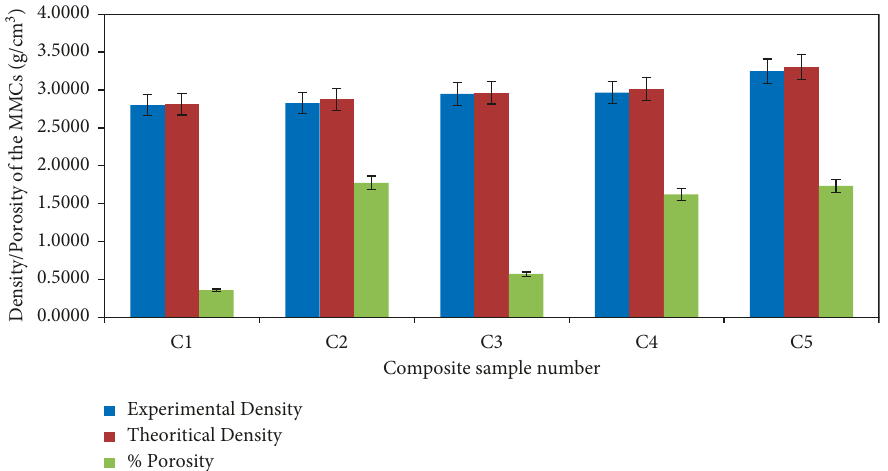
Figure 11: Deviation of density and percentage porosity of the developed hybrid MMCs.